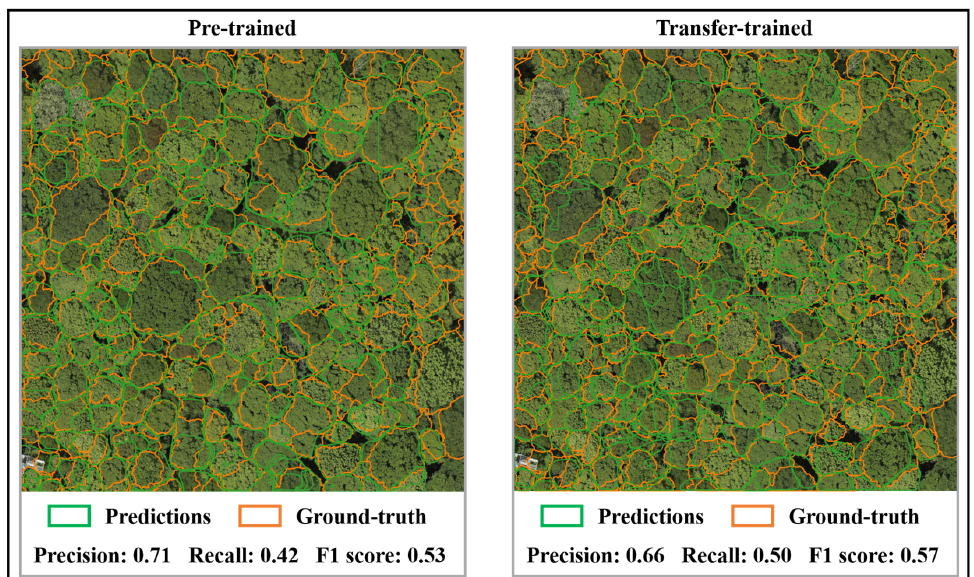
Figure 3. The tree crown detection of the pre- and transfer-trained DeepForest methods derived from UAV-based RGB imagery in the studied temperate, deciduous forest. The green and orange bounding boxes represent the predicted and ground truth tree crowns.